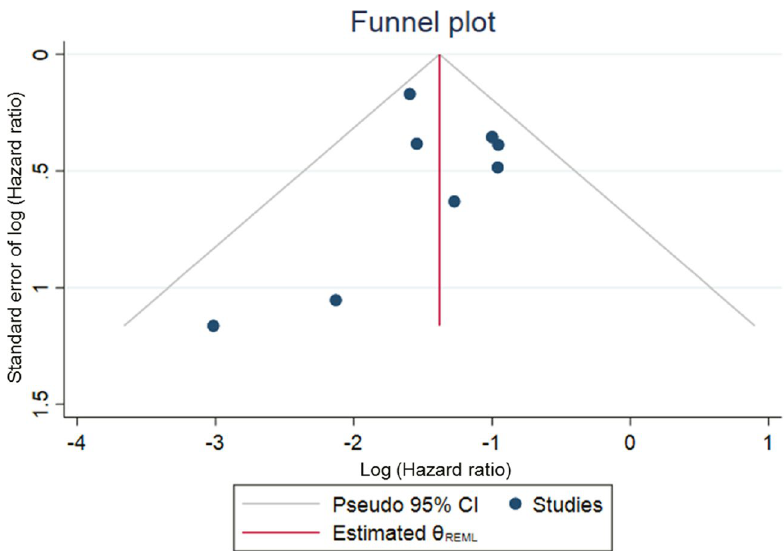
Figure 3. Funnel plot evaluating the publication bias of 8 studies used to determine the pooled estimate of the hazard ratio of HCC incidence adjusted for potential covariates in patients treated with antiviral therapy (SVR vs . non-SVR). HCC hepatocellular carcinoma, SVR sustained virologic response, CI confidence interval.